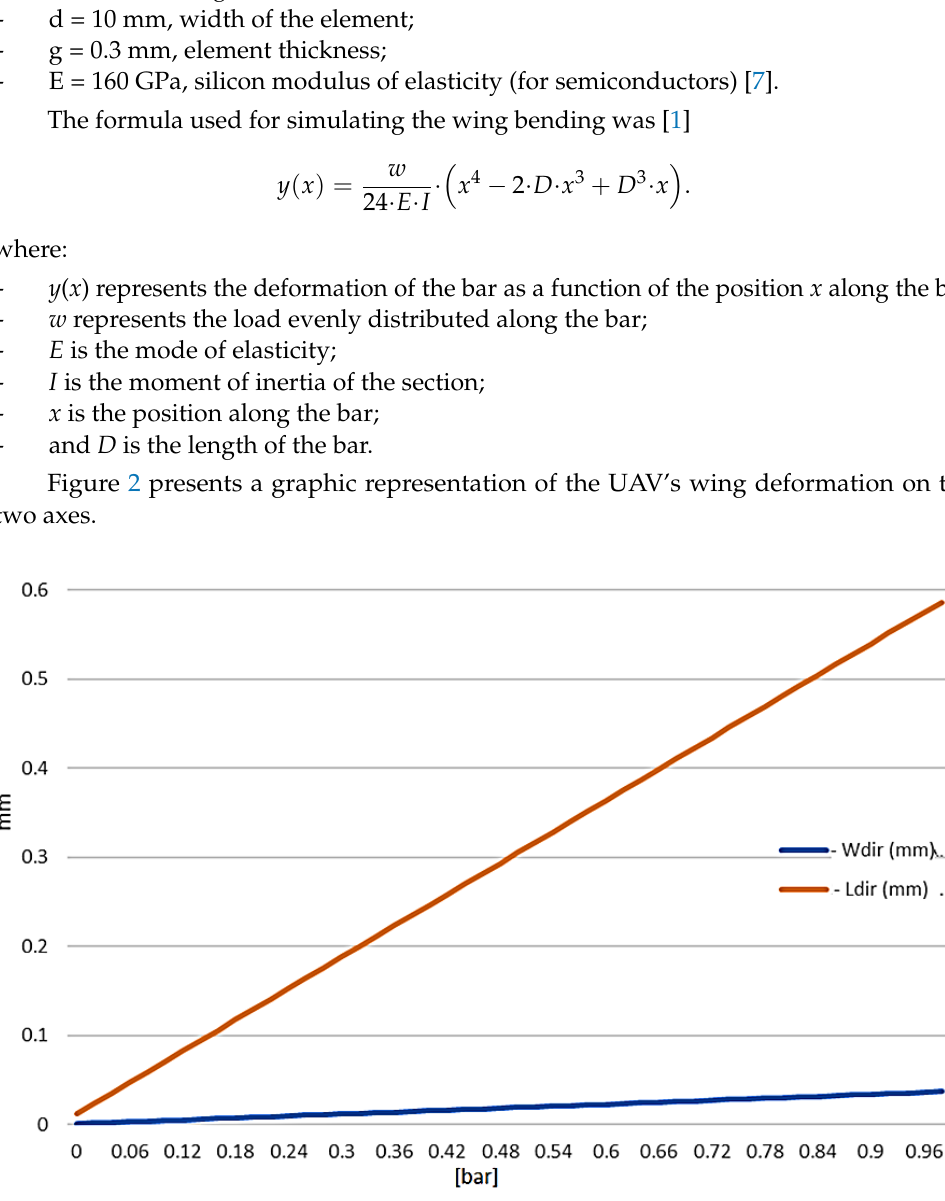
Figure 2. UAV’s wing deformation on the two axes.